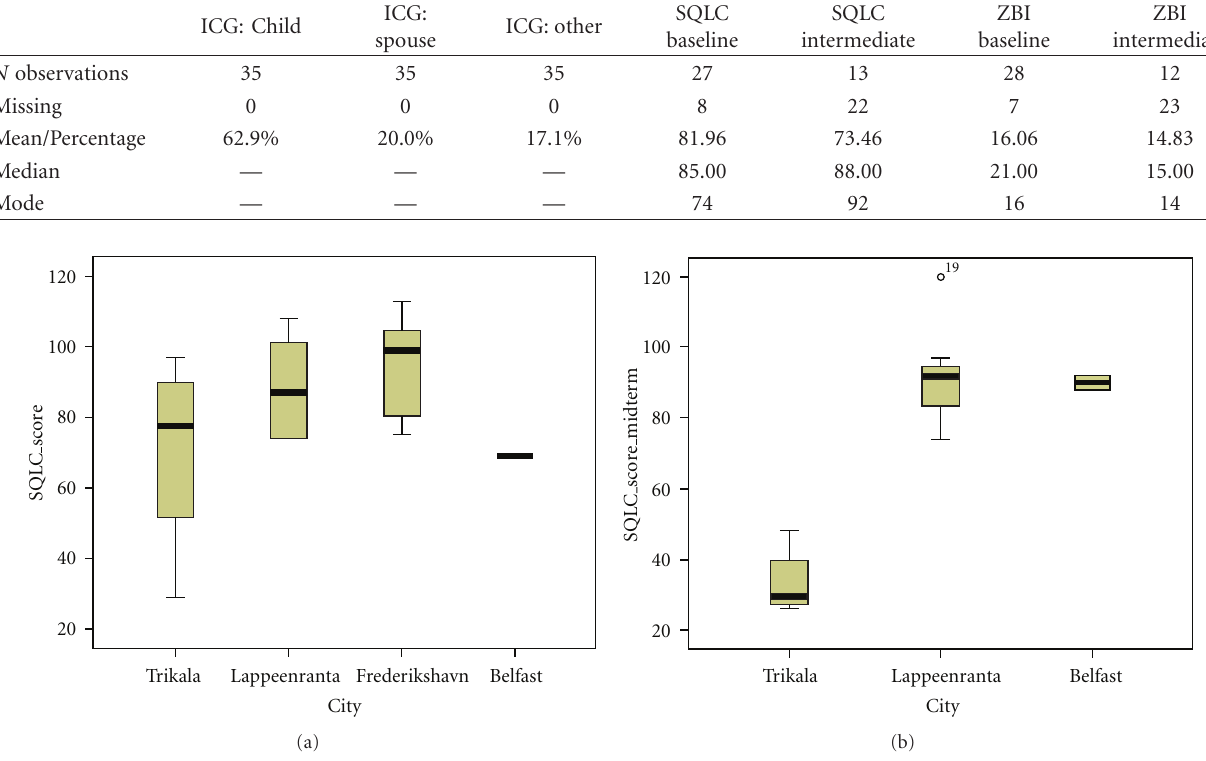
Figure 3: Boxplots of SQLC scores (baseline N = 27, intermediate N = 13) according to